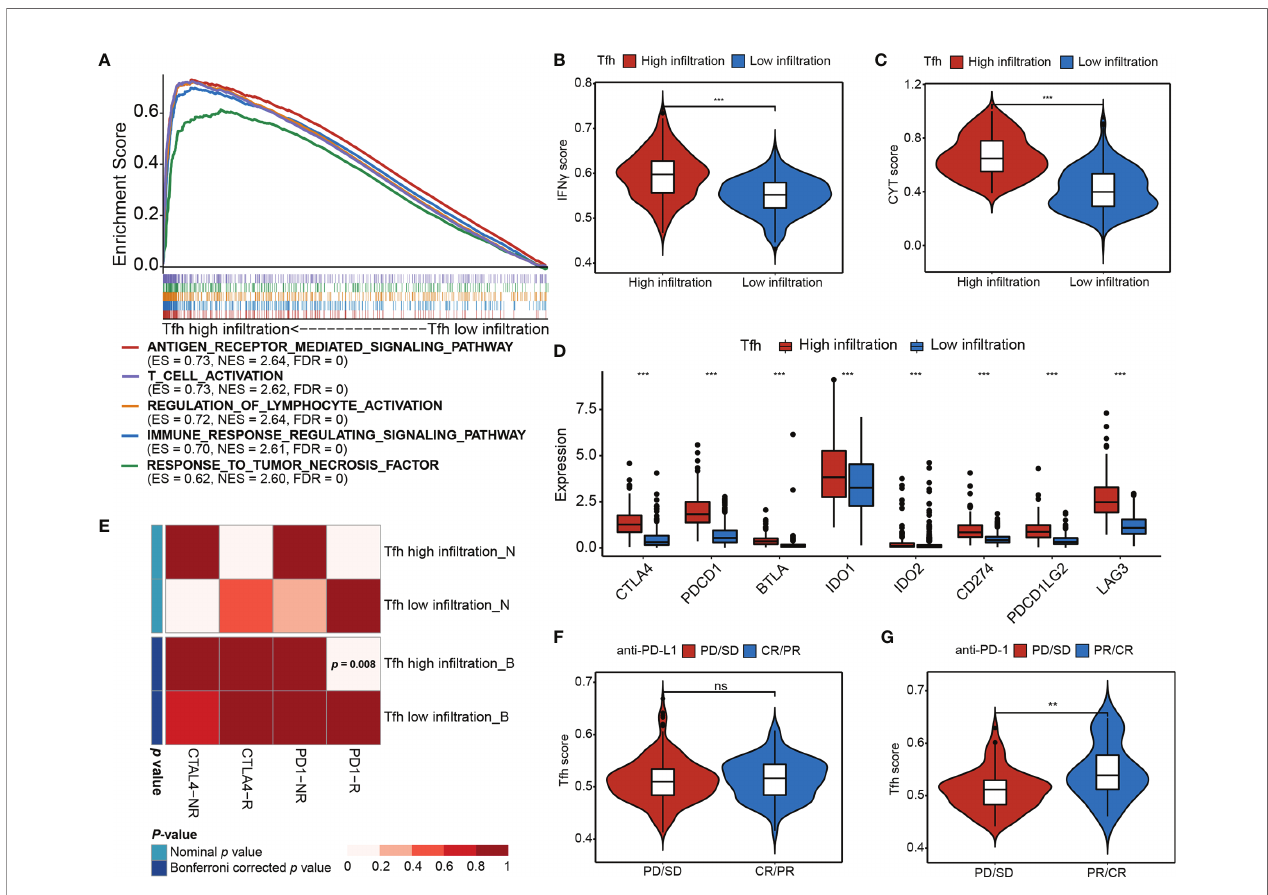
FIGURE 4 | Differential immunotherapeutic response in Tfh subtypes. (A) GSEA of the top fi ve signi fi cant Gene Ontology biological processes based on the enrichment scores. FDR < 0.01. (B, C) Distribution of the IFN g score (B) and CYT score (C) in high- and low-Tfh in fi ltration groups. Middle line: median; box edges: 25th and 75th percentiles, whiskers: most extreme points. *** p < 0.001, Wilcoxon rank-sum test. (D) Distribution of the gene expressions ( y -axis) of eight immune inhibitory checkpoints in high- and low-Tfh in fi ltration groups. Middle line: median; box edges: 25th and 75th percentiles, whiskers: most extreme points. *** p < 0.001, Wilcoxon rank-sum test. (E) Submap analysis of the published dataset with immunotherapy response data indicates that the Tfh high in fi ltration group could be more sensitive to the anti ‐ PD ‐ 1 therapy (Bonferroni ‐ corrected p = 0.008). (F, G) Distribution of the Tfh score of anti-PD-L1 therapy status (F) and anti-PD-L1 therapy status (G) in high- and low-Tfh in fi ltration groups. Middle line: median; box edges: 25th and 75th percentiles, whiskers: most extreme points. ** p < 0.01, Wilcoxon rank-sum test. ns, non signi fi